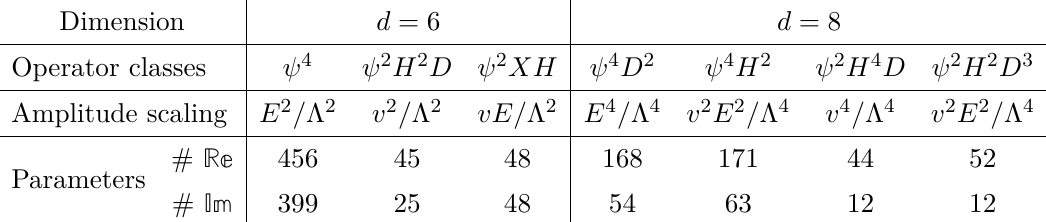
Table 1. Counting of SMEFT parameters relevant to the high- p T observables and the correspond- ing energy scaling of the amplitude for each class of operators. The number of real and imaginary free parameters that contribute to the Drell-Yan cross-sections at order O (1 / Λ 4 ) are listed for each operator class. In total we find 549 (472) real (imaginary) parameters at d = 6 and an additional 435 (141) real (imaginary) parameters at d = 8 , where for the latter we only consider those param- eters that affect the interference of these operators with the